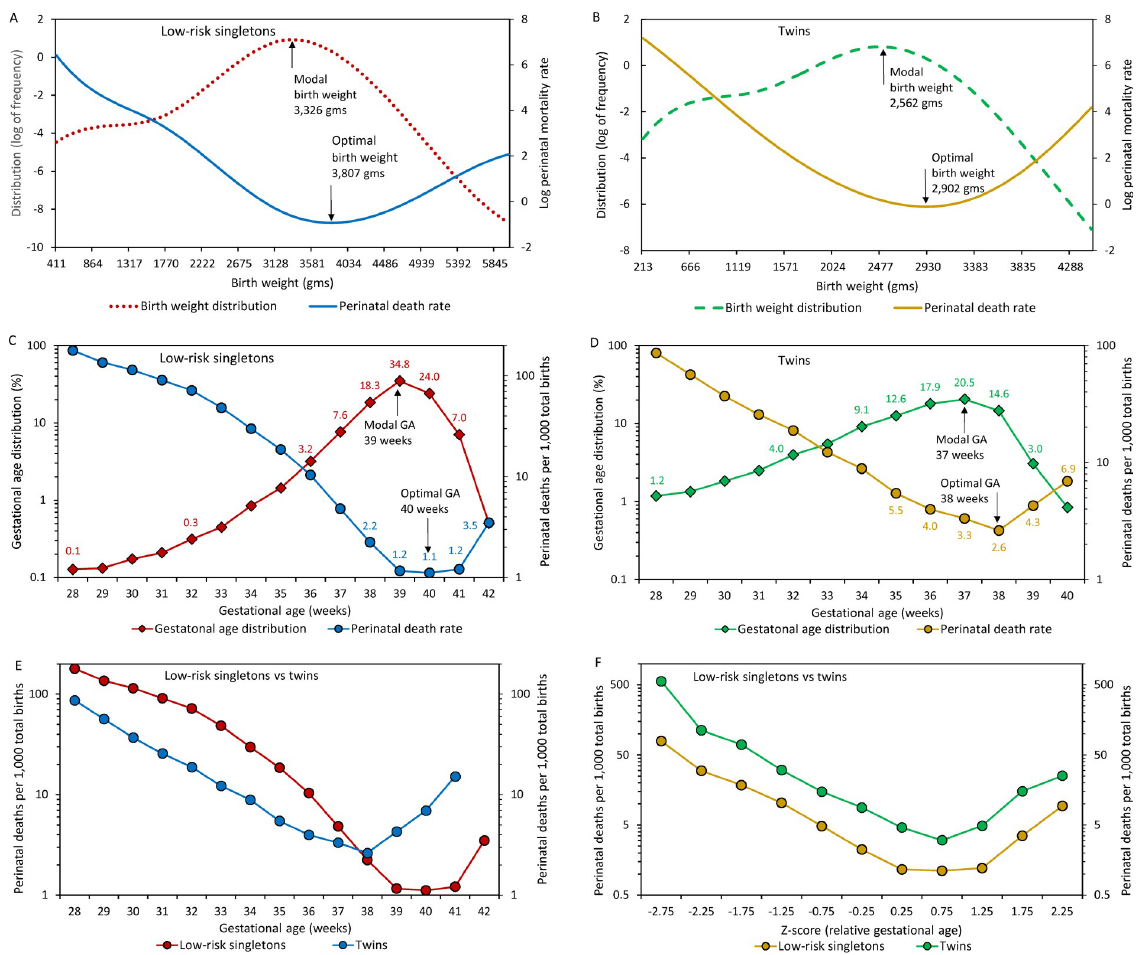
Fig 1. Birthweight distributions and birthweight-specific perinatal death rates among singletons of low-risk women (i.e., without hypertension or diabetes; Panel A) and twins (Panel B); gestational age distributions and gestational age-specific perinatal death rates among singletons of low-risk women (Panel C) and twins (Panel D); and births-based gestational age-specific perinatal death rates (Panel E) and births-based relative gestational age-specific perinatal death rates (Panel F) among singletons of low-risk women and twins, United States,